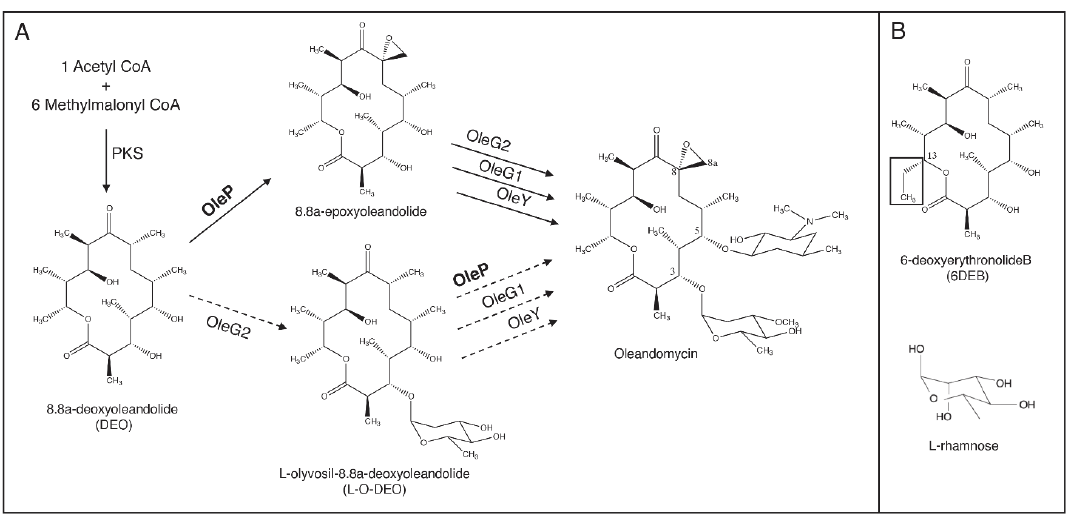
Figure 1. The biosynthetic pathway of oleandomycin. ( A ) OleP is active during the final steps of the biosynthesis of the antibiotic oleandomycin, where it catalyzes a reaction of epoxidation at the C8-C8a bond of the macrolactone ring. According to Gaisser et al. [12], OleP may introduce the epoxide function both to the aglycone and to the C3-monoglycosylated intermediates, splitting the process into two parallel pathways. In the figure, the pathways are distinguished by continuous and dotted arrows, respectively representing the epoxidation occurring on the aglycone intermediate DEO and the one performed on the monoglycosylated L-O-DEO. ( B ) The chemical structure of 6DEB and L-rhamnose are reported. A black square indicates the different substituent group at C13 of 6DEB with respect to DEO.